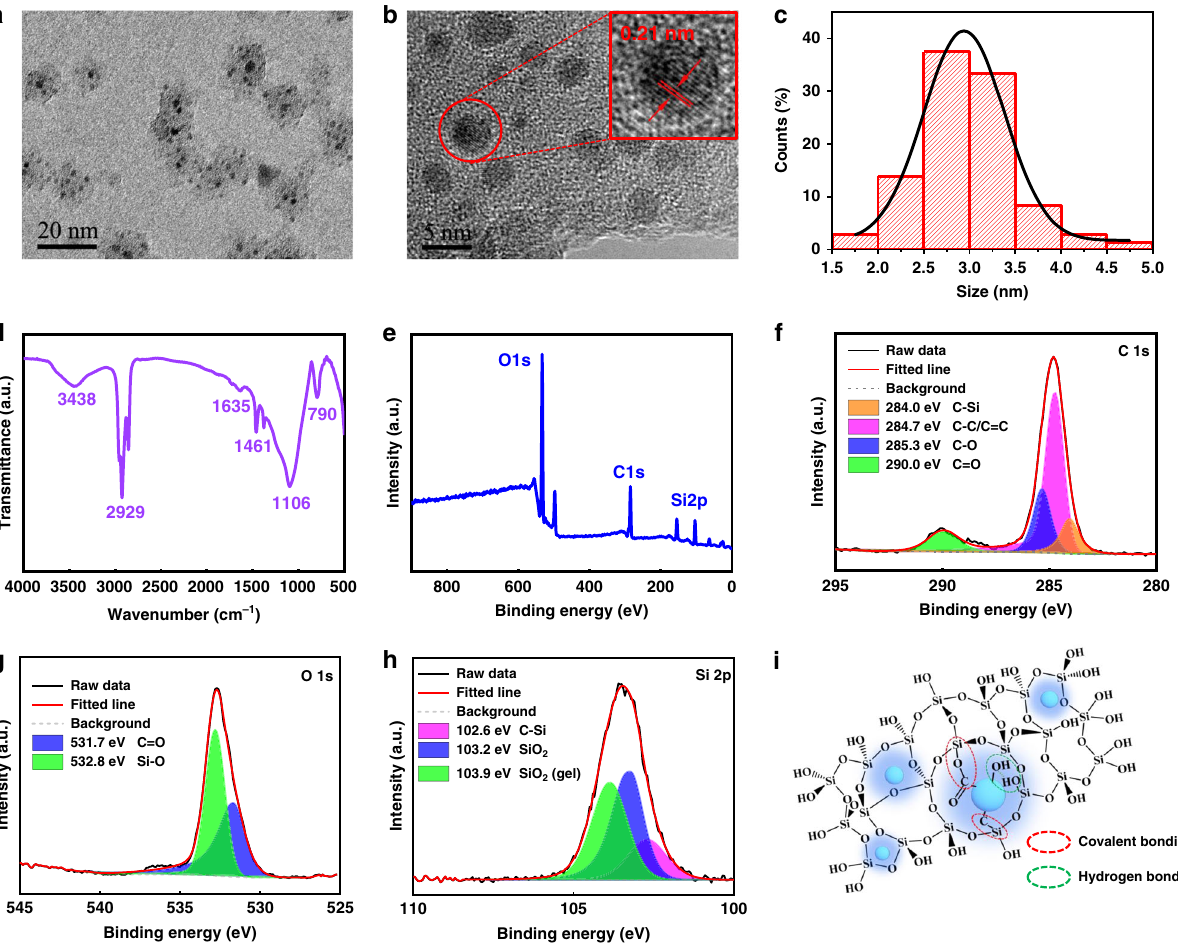
Fig. 3 Morphology, FTIR, and XPS characterization of the CDs@SiO 2 . a TEM and b HRTEM images of CDs@SiO 2 -600. c Size distribution histogram of the CDs in SiO 2 matrix prepared at 600°C. d FTIR spectrum and e XPS survey spectrum of CDs@SiO 2 -600. f – h High resolution XPS spectrum and fi tting results of C 1s ( f ), O 1s ( g ), and Si 2p ( h ) in CDs@SiO 2 -600. i Schematic of the proposed structure of CDs@SiO 2